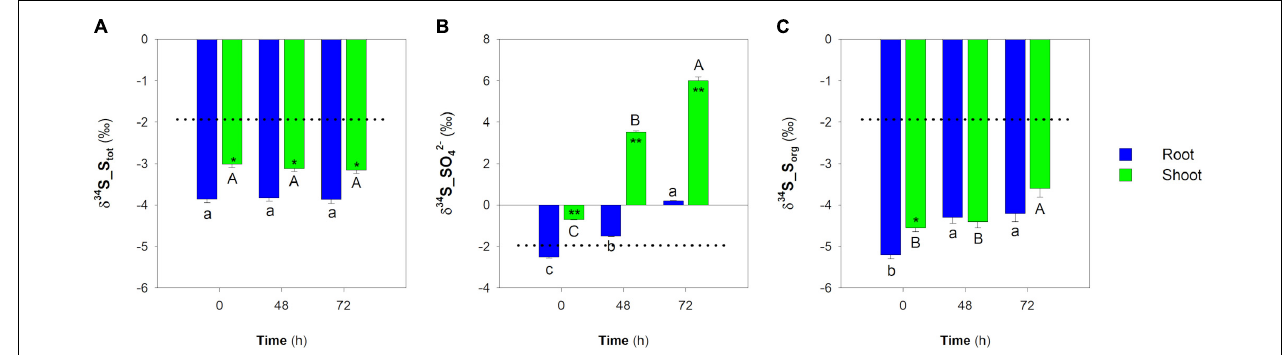
FIGURE 6 | Sulfur isotope composition of the main S pools in root and shoot of rice plants grown in the absence of SO 42 − in the hydroponic solution. (A) S isotope composition of S tot in root and shoot. (B) S isotope composition of SO 42 − in root and shoot. (C) S isotope composition of S org in root and shoot. Data are means ± SE of three independent experiments run in duplicate ( n = 3). Asterisks indicate significant differences (Student’s t -test; *0.001 ≤ P < 0.05; ** P < 0.001) between root and shoot of plants sampled at the same time. Different letters indicate significant differences between the samples (root and shoot) at different times ( P < 0.05).